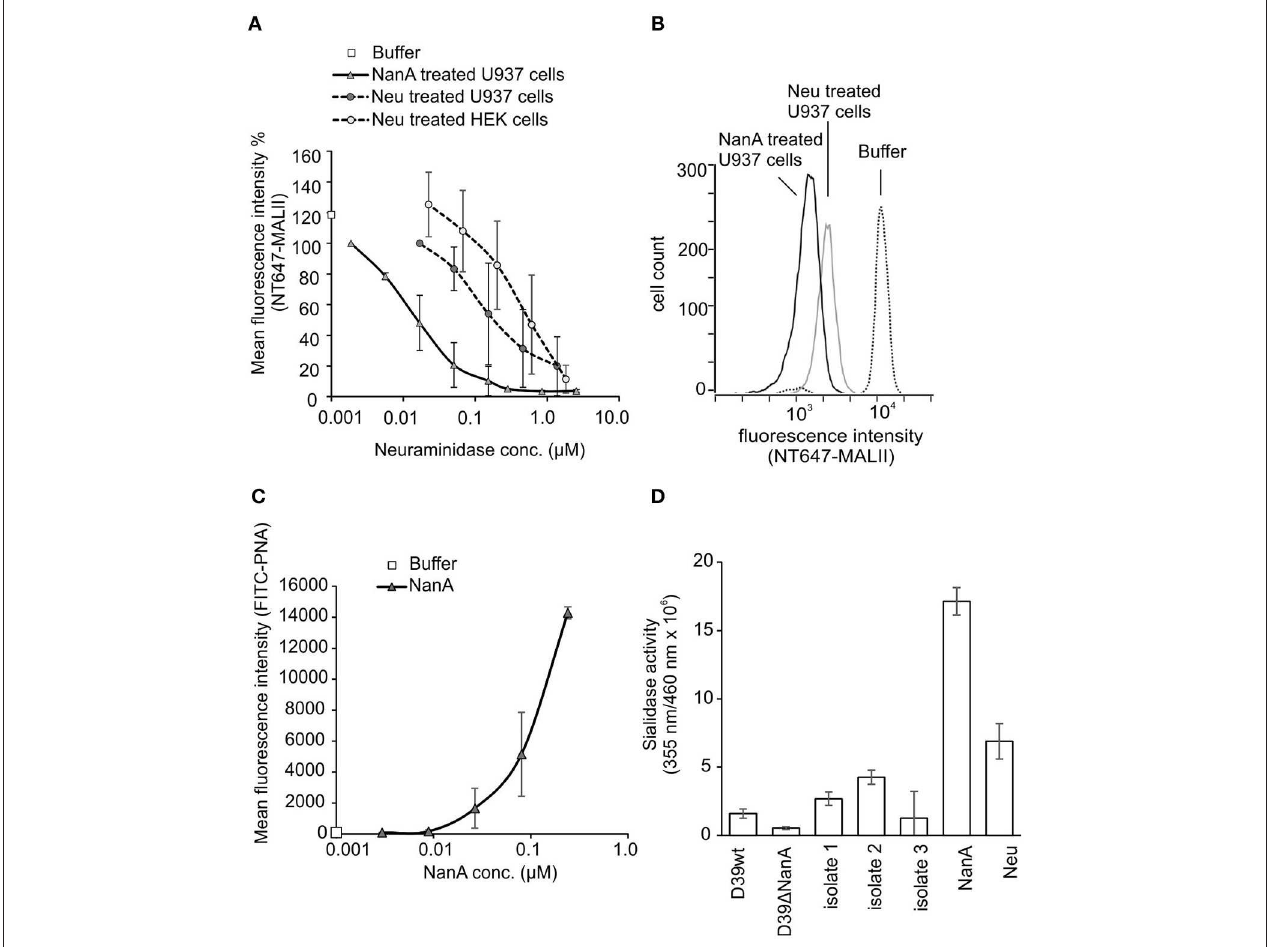
FIGURE 1 | Removal of sialic acids from cell surfaces by RecNanA (NanA) and C. perfringens neuraminidase (Neu). 2.2 × 10 4 of U937 or HEK cells were incubated with increasing concentrations (nM range) of NanA or Neu. Sialic acid removal was detected by flow cytometry using (A,B) sialic acid-specific NT647-labeled MAL-II lectin ( n = 2) or (C) galactose-specific peanut agglutinin (PNA) ( n = 2). (A) Levels were calculated as relative mean fluorescence intensity of NT647-MAL-II without neuraminidase. (B) Histogram showing distribution of MALII binding on U937 cells in the presence of 300nM NanA, Neu or buffer. (C) Increase of FITC-PNA binding upon removal of sialic acids was detected with increasing concentrations of NanA. (D) Sialidase activities of the purified proteins RecNanA (10nM of NanA) and C. perfringens neuraminidase (110nM of Neu) and the bacterial supernatants (50%) from S. pneumoniae wild type D39 strain D39 nanA (D39 1 nanA) mutant and the clinical isolates. Error bars indicate